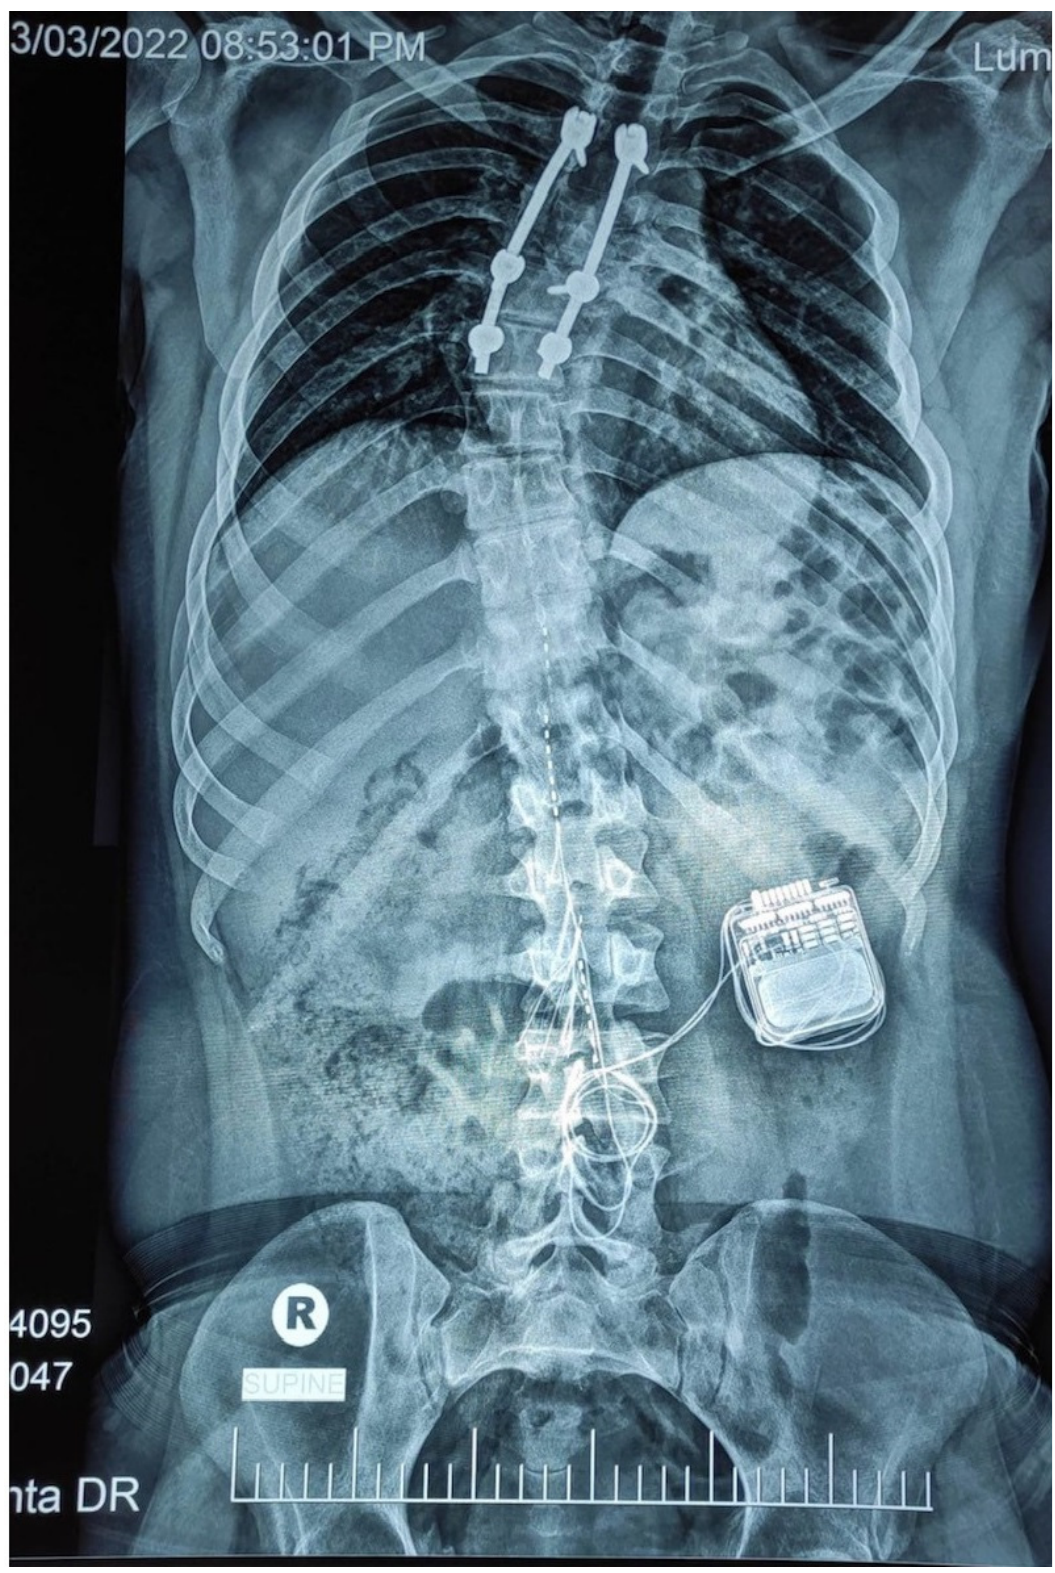
Figure 2. The unexpected left lead migration detected by X-ray. The migration was detected 5 days post-implantation as a result of traveling in a car for close to 250 km to return home. The right lead also migrated to cover the T12–L1 vertebrae.